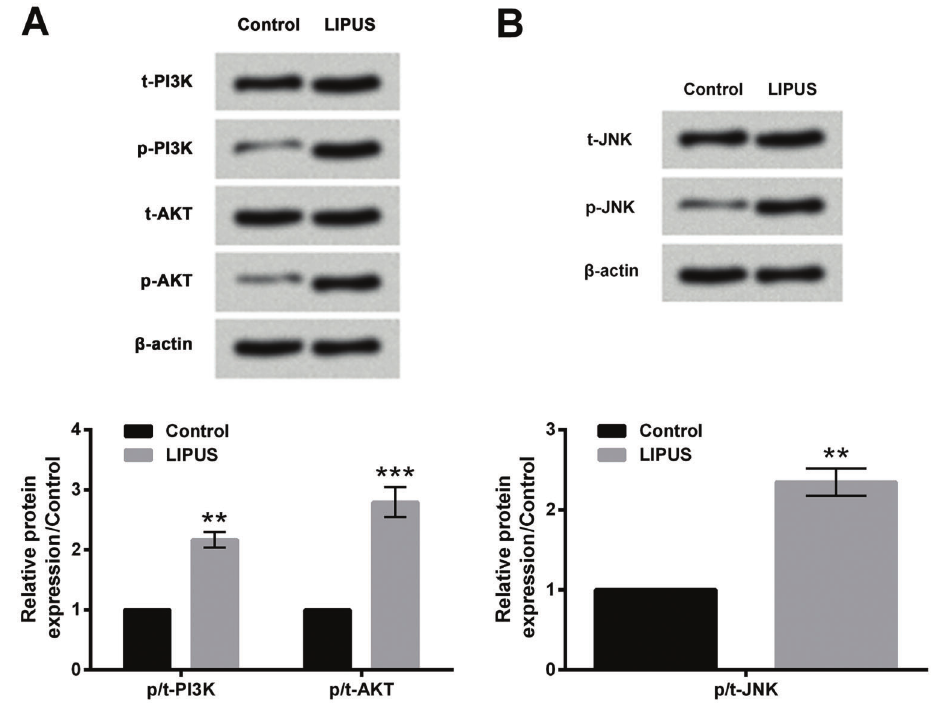
Figure 3. Low-intensity pulsed ultrasound (LIPUS) activated the PI3K/AKTand JNK pathways in HaCaTcells. Expression of key kinases in the PI3K/AKT pathway ( A ) and the JNK pathway ( B ) were evaluated by western blot. Data are reported as means ± SD of three independent experiments. **P o 0.01, ***P o 0.001 compared to control (Student ’ s t